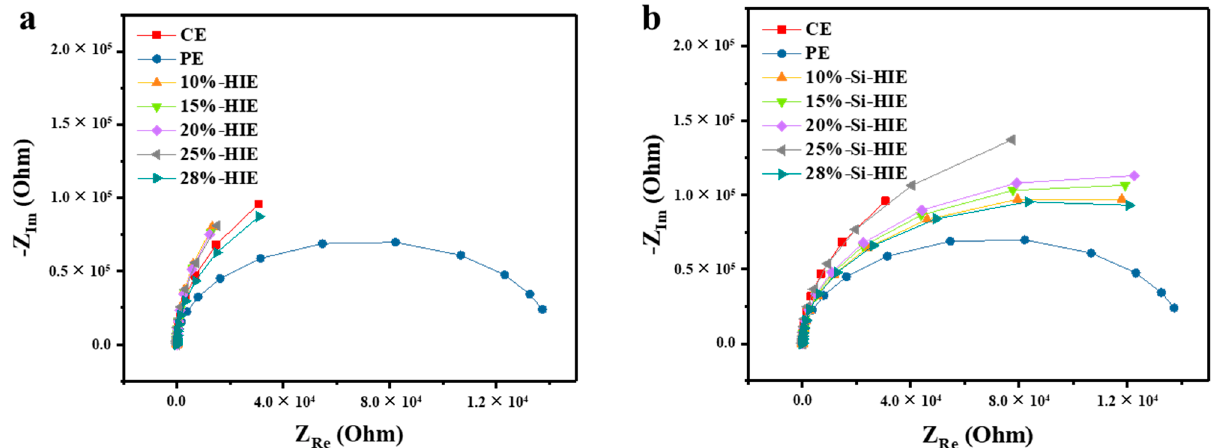
Figure 3. Fitted Nyquist plots corresponding to EIS results for ( a ) N%-HIE and ( b ) N%-Si-HIE as compared to CE and PE in saline solution (N = 10, 15, 20, 25 and 28%). Data obtained at 300 mHz–300 kHz, V = 30 mV.